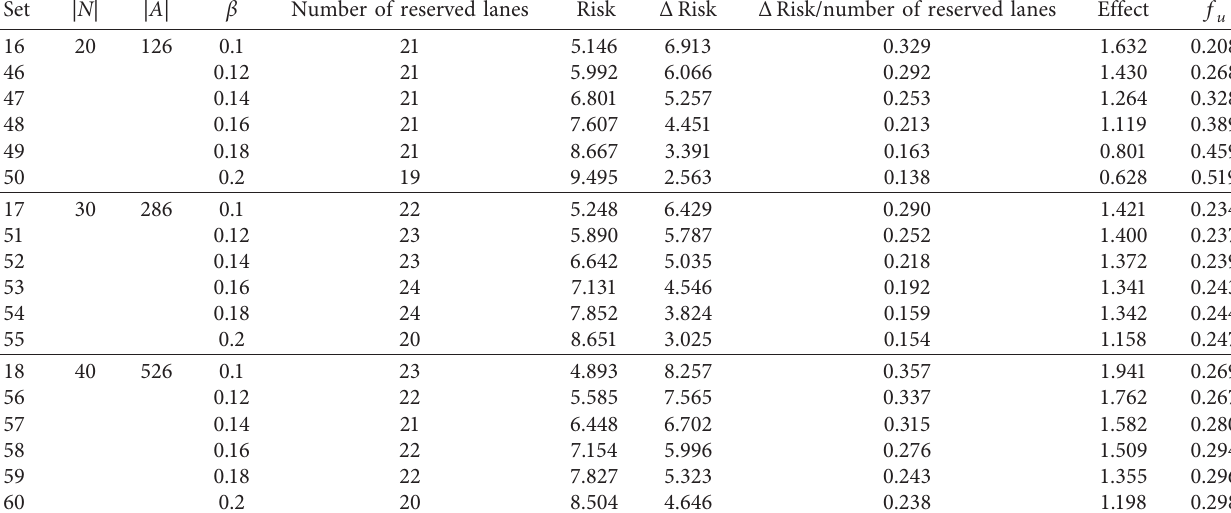
Table 10: Result of experiments with varied β , when | W |� 20, α � 0.1, and λ �